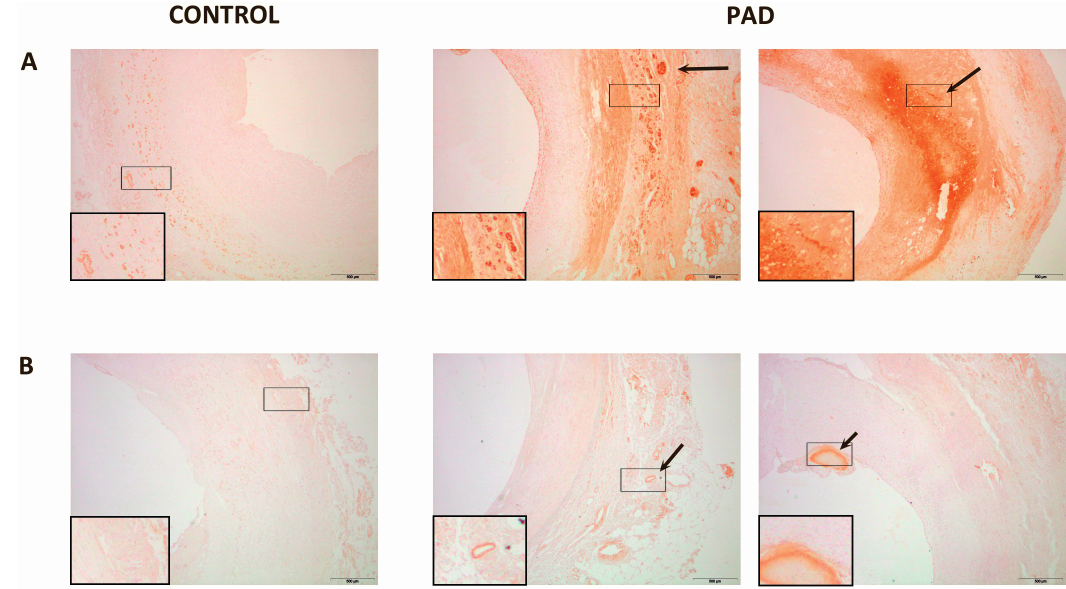
Figure 2. Representative immunohistochemical images for paraoxonase-1 (PON1) and paraoxonase-3 (PON3) staining of peripheral arteries: ( A ) PON1 expression in normal artery was almost undetectable, and located in the media and adventitia. PON1 had two types of localization in affected arteries: when the intima was not very thick, PON1 was located in the adventitia and media of the vessels (arrow). When the intima was disorganized and with cholesterol deposits, PON1 was expressed in the lesion site (arrow); ( B ) PON3 expression was undetectable in normal tissue whereas, in affected arteries, PON3 was located in the adventitia or in the injury sites of the intima (arrow). Magnification 20×. The inserts show higher magnification (100×) images of the indicated